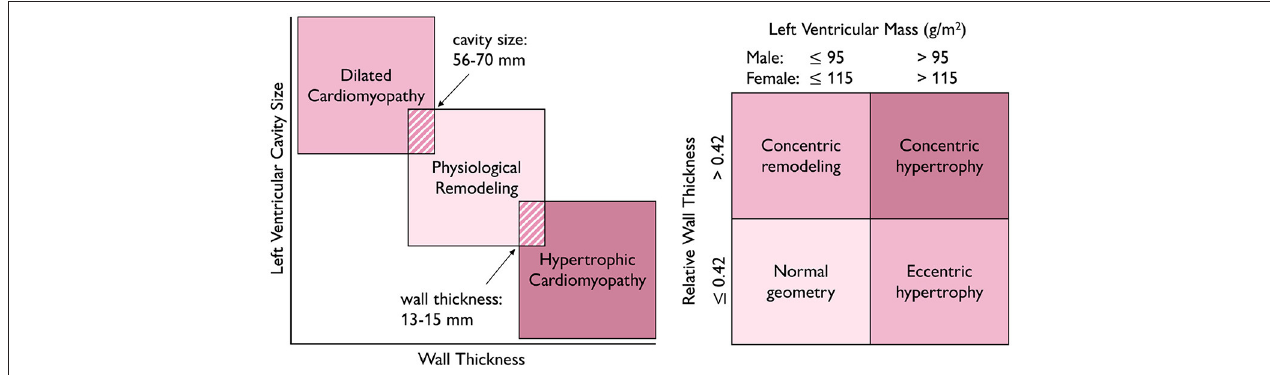
FIGURE 8 | Differentiating physiological from pathological adaptation. Wall thickness and cavity size are diagnostic criteria for which a subset of physiologically remodeled athlete’s hearts overlaps with pathologically remodeled dilated and hypertrophic cardiomyopathy hearts, left. Relative wall thickness and sex-specific left ventricular mass are criteria which differentiate normal geometry from hypertrophic, even in the case of extreme athletic adaptation,